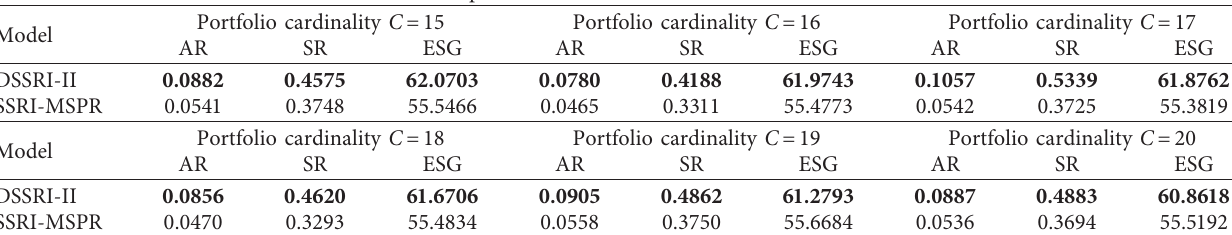
Figure 2: Performance of the DSSRI-I and the SSRI-GMV at different portfolio cardinalities. Table 5: Comparison of the DSSRI-II and the SSRI-MSPR.